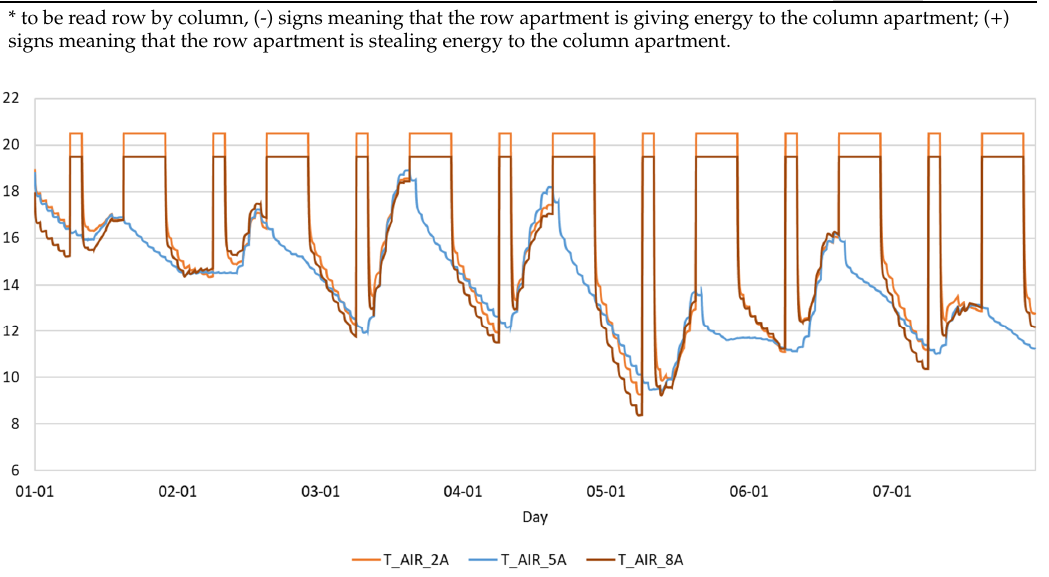
Figure 9. Indoor temperature variation of apartments 2A, 5A and 8A in a representative week of the heating season, scenario a.